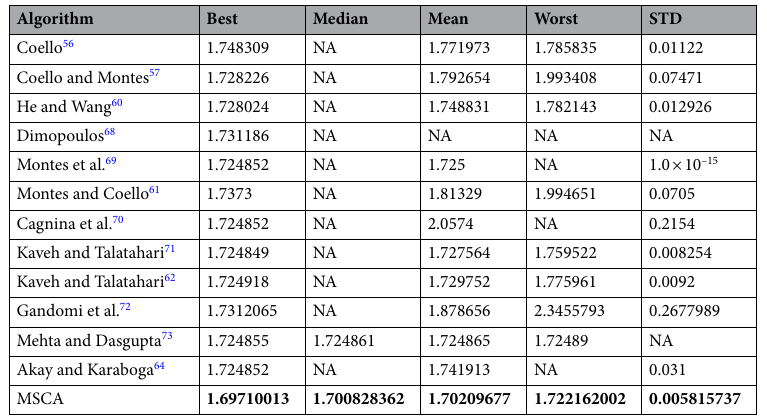
Table 18. Statistical result for welded beam design problem on version II. NA means not available. Significant values are in bold.